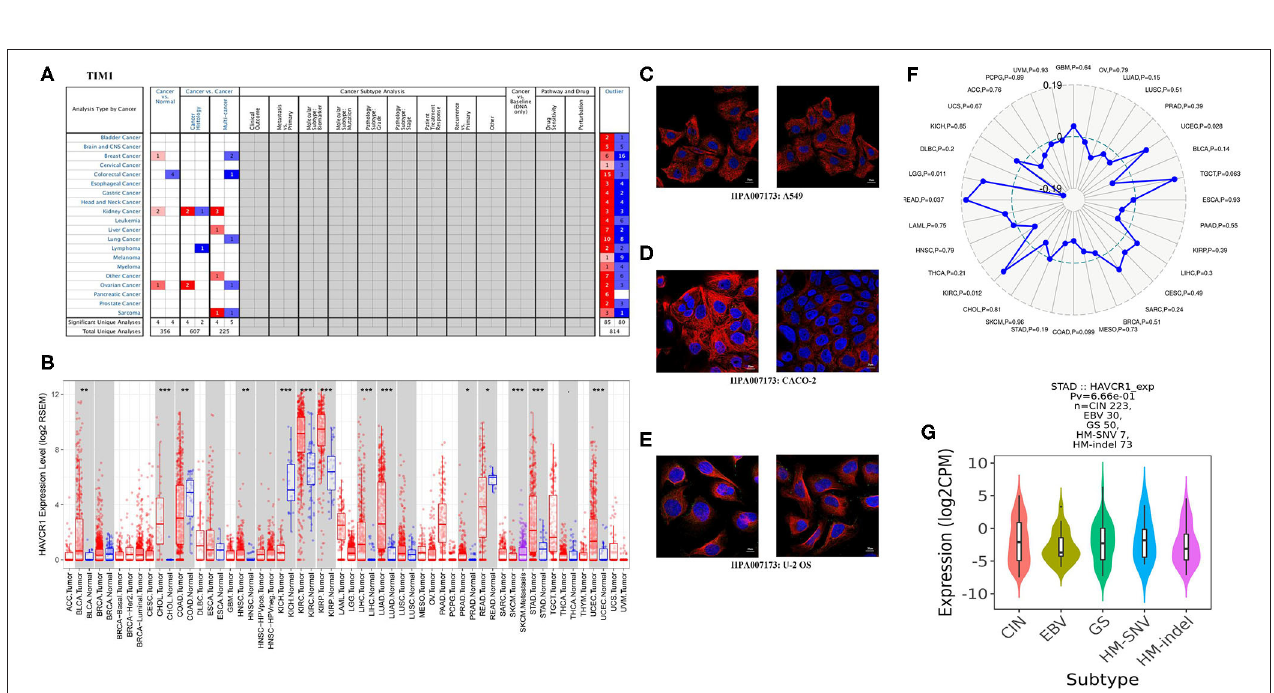
FIGURE 2 | TIM-1 expression levels in different types of human cancers. (A) Increased or decreased TIM-1 in datasets of different cancers compared with normal tissues in the Oncomine database. (B) TIM-1 expression levels in different tumor types from TCGA database were determined by TIMER ( * P < 0.05, ** P < 0.01, *** P < 0.001). (C–E) The distribution of TIM-1 in A549 cells, CACO-2 cells, and U-2 OS cells, blue represents nucleus, red represents microtubules, green represents antibody. (F) Correlation of TIM-1 expression and MSI in cancers. (G) Correlation of TIM-1 expression and molecular subtypes (CIN, EBV, HM-SNV, HM-indel) in STAD.